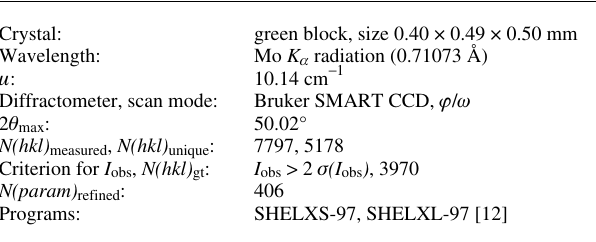
Table 1. Data collection and